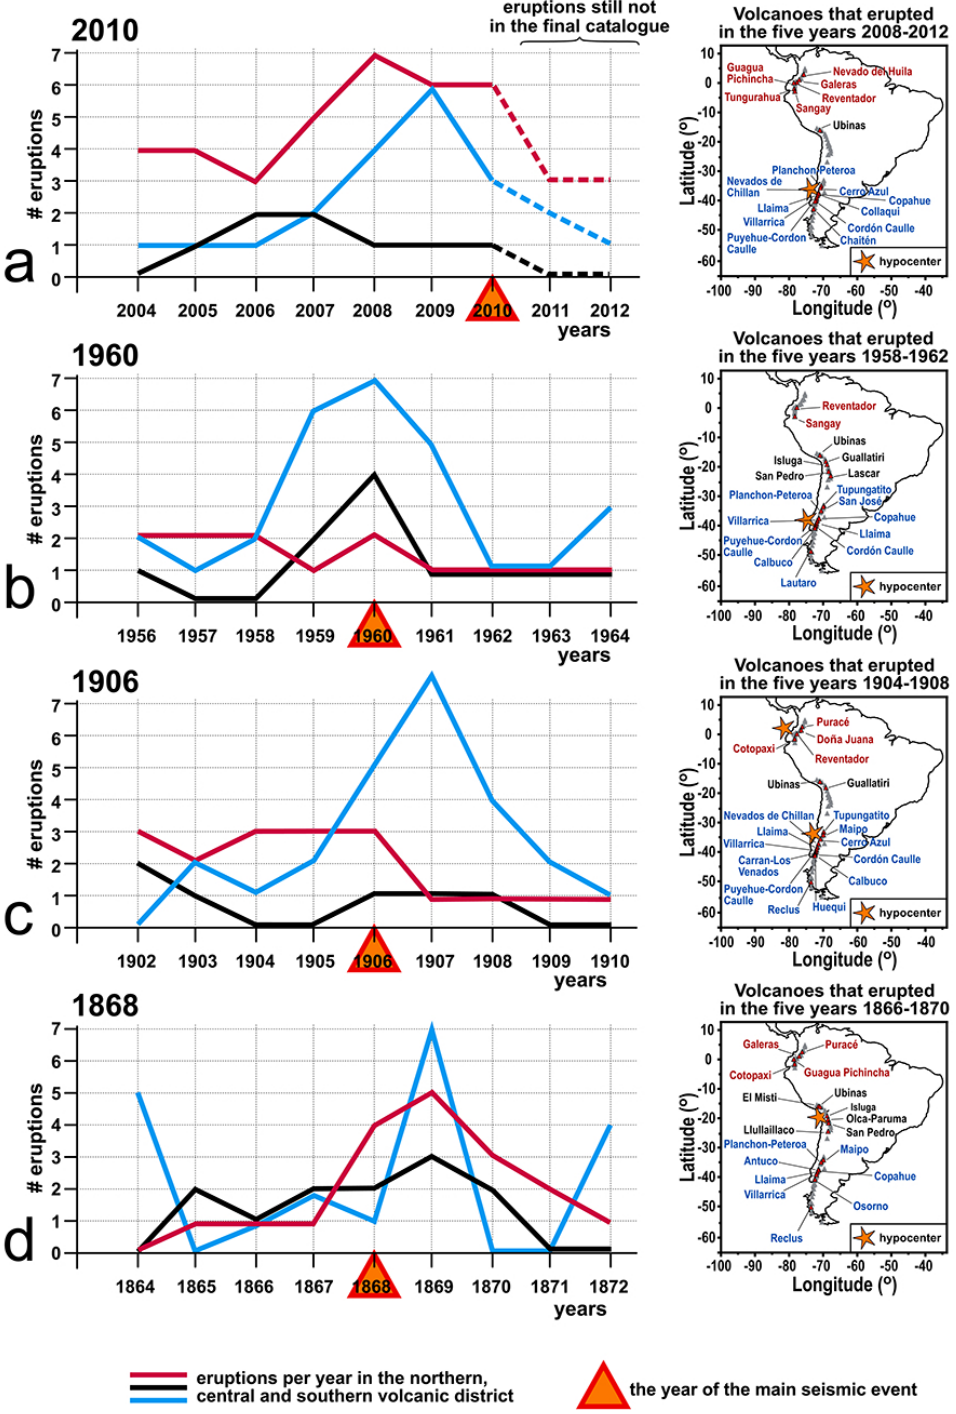
Fig. 4. Details of the eruption rates separated according to the three volcanic districts. The colours are assigned as in Fig. 1. The trend toward a precursory occurrence of a higher eruption rate is clear passing from the 1868 to the 2010 correlation event. The central volcanic district seems somewhat passive in producing high eruption rates, even on the occasion of the 1868 earthquake that occurred near the central district. The southern district was involved in all the four events. The higher eruption rates of both the northern and southern districts in 1868 and 2010 are evidence of a possible link with global geodynamic